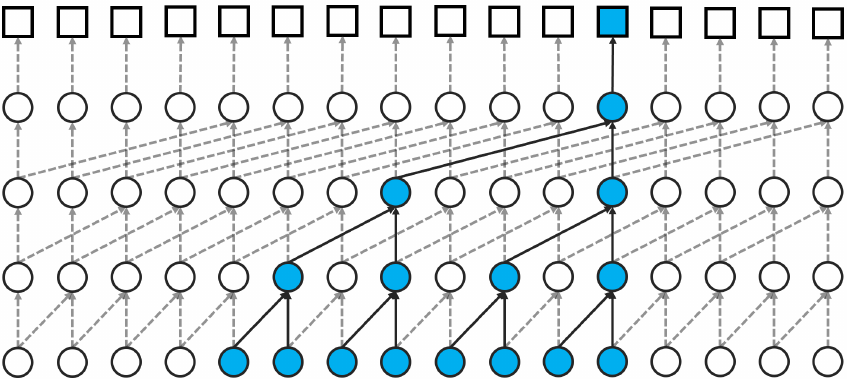
Figure 4. Learning process of temporal convolution network (TCN) (Note: Blue denotes the number of nodes needed in current